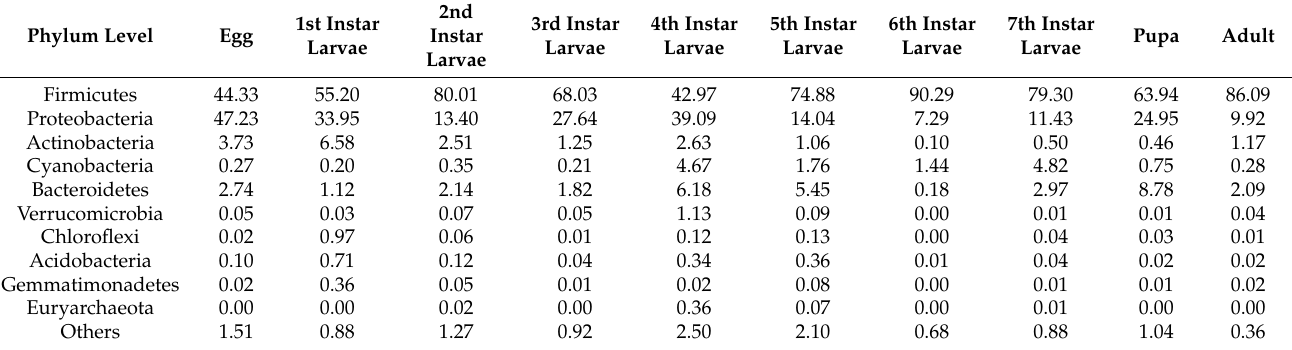
Table A3. The top 10 phyla with the highest relative abundance levels in the gut microbiota of L. xylina during different developmen- tal stages.